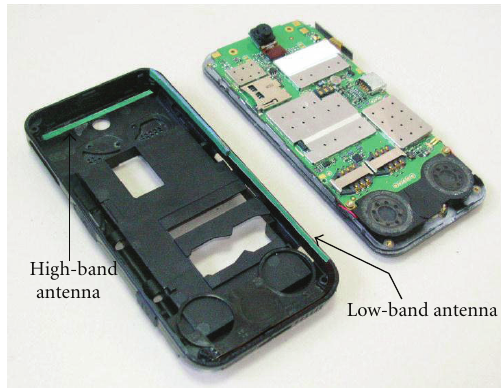
Figure 10: Mutual coupling ( S 12 ) between the antennas of the second configuration while the antennas are perpendicular to each other.